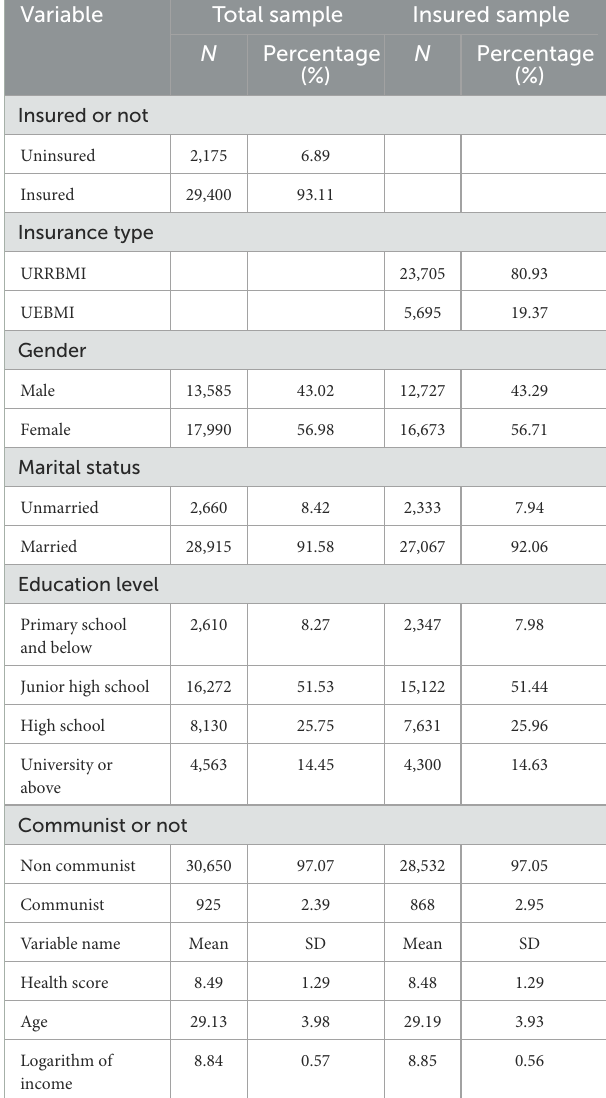
TABLE 1 Descriptive statistics of main